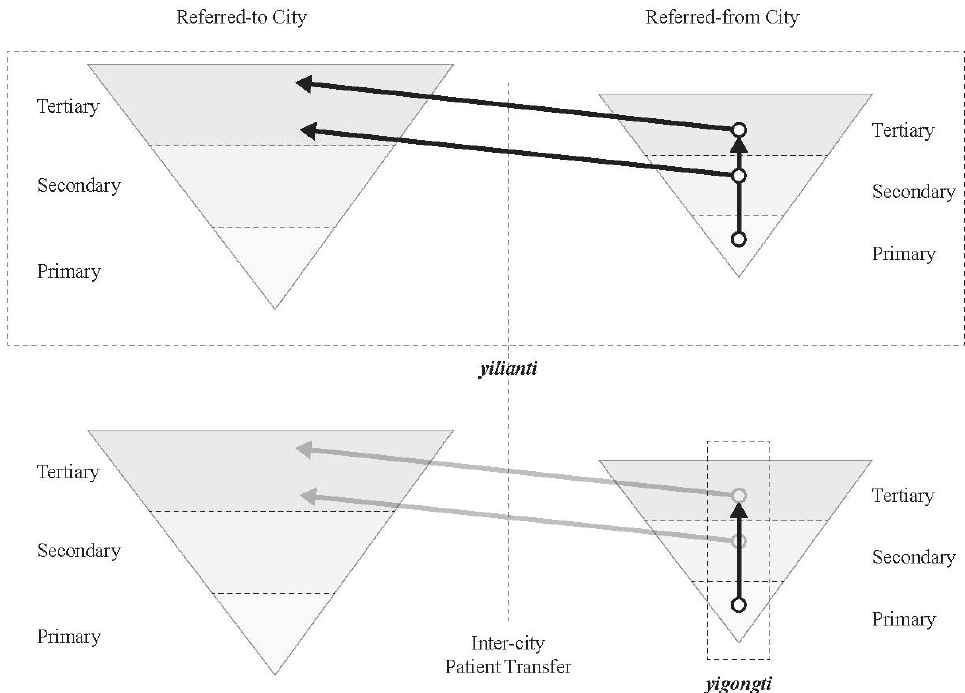
Figure 1. Patient referrals of yilianti and yigongti.